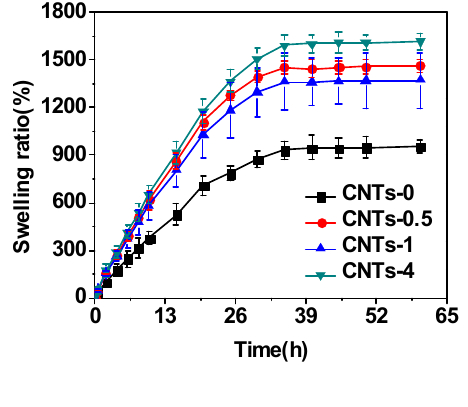
Figure 1. The swelling curves of nanocomposite DN hydrogels composited with various CNTs